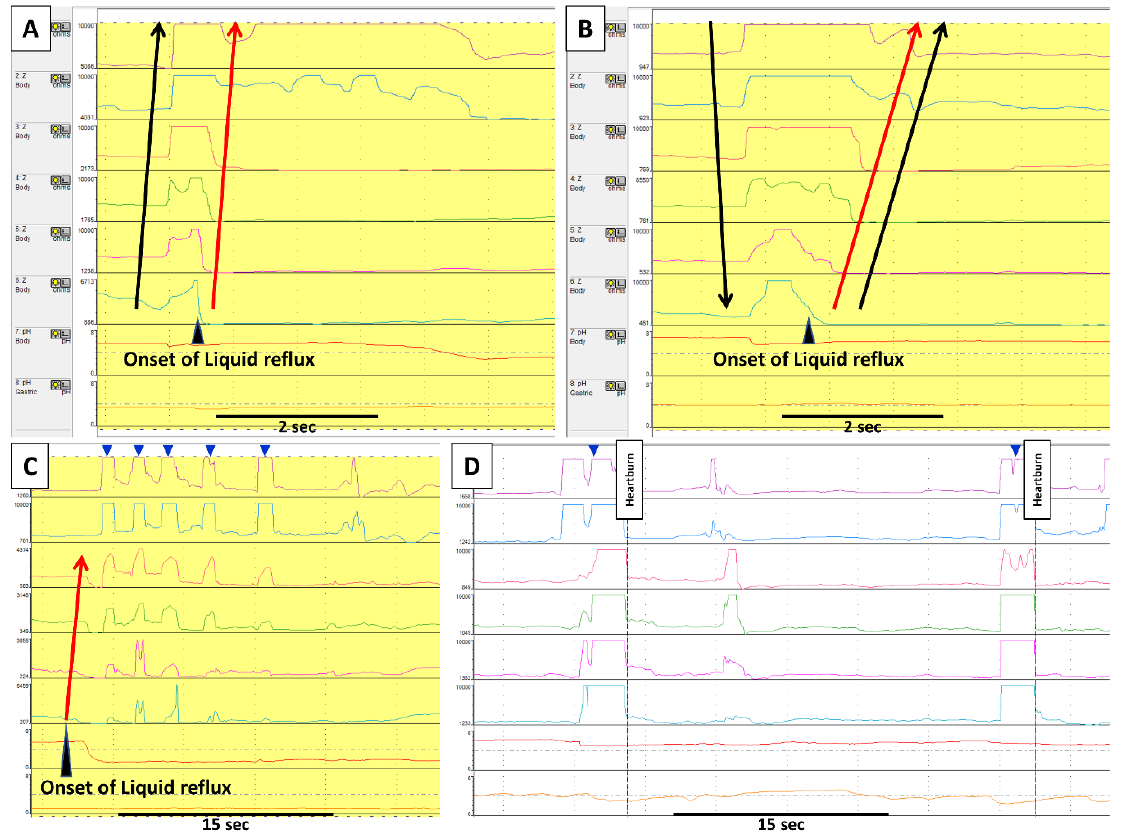
Figure 1. Gastric belching and supragastric belching in impedance–pH monitoring. Each row in impedance–pH tracings measures, from the bottom, gastric pH; esophageal pH at 5 cm above the lower esophageal sphincter (LES); and impedance at 3, 5, 7, 9, 15, and 17cm above the LES. In GB ( A ), an increase of impedance, indicating air from the stomach, moves retrogradely from the distal to the proximal esophagus. This GB is immediately followed by a liquid reflux episode (i.e., retrograde impedance decrease). On the other hand, SGB ( B ) starts with antegrade movement of impedance increase by sucking or swallowing air from the pharynx; subsequently, such increase returns to baseline retrogradely by abdominal straining. This SGB induces a liquid reflux episode. Apart from the SGB inducing reflux, there are two other patterns of the relationship between SGB and reflux. ( C ) shows that several SGBs (blue arrowheads) occur during liquid reflux in which an uncomfortable sensation by reflux might lead a patient to perform SGBs. ( D ) shows SGBs (blue arrowheads) without reflux. In this case, a patient constantly marked heartburn immediately after SGBs, which suggests the SGBs caused reflux symptoms by esophageal distension. Black arrows indicate the movement of air, whereas red arrows indicate liquid reflux.